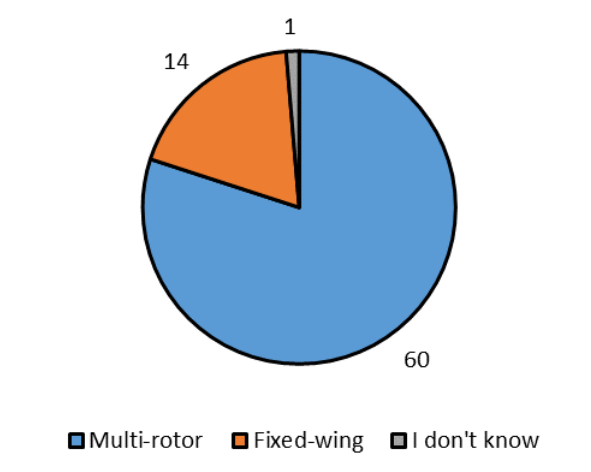
Figure 8 Used types of UAV